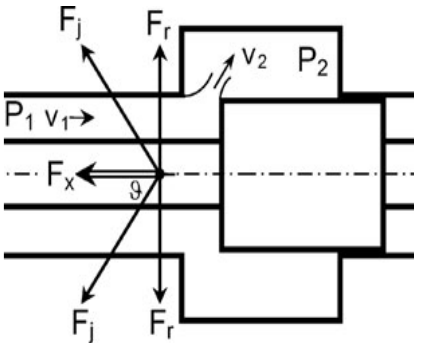
Figure 5 The effect of hydraulic flow force on the valve